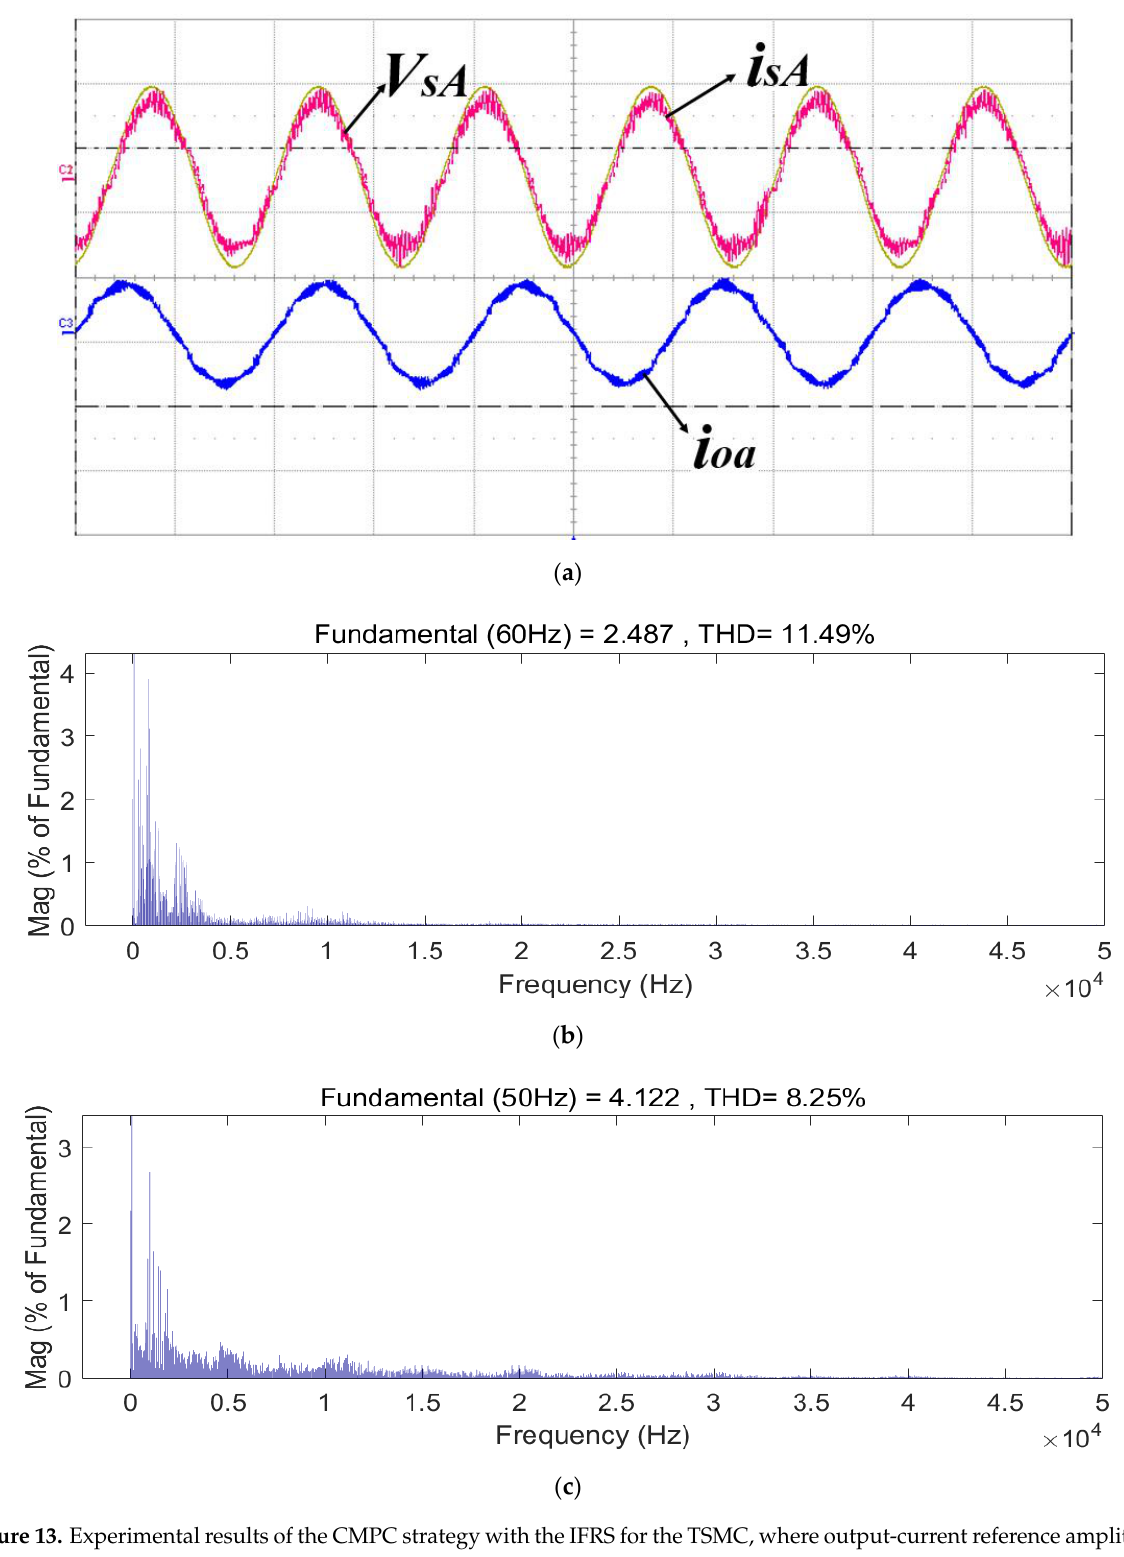
Figure 13. Experimental results of the CMPC strategy with the IFRS for the TSMC, where output-current reference amplitude is set to 4.3 A and output-current frequency is set to 50 Hz, x-axis 10 ms/div ( a ) Waveforms of the source voltage 𝑉 𝑠𝐴 (100 V/div), source current 𝑖 𝑠𝐴 (2 A/div) and output current 𝑖 𝑜𝑎 (5 A/div). ( b ) Spectrum distribution of 𝑖 𝑠𝐴 . ( c ) Spectrum distribution of 𝑖 𝑜𝑎 .